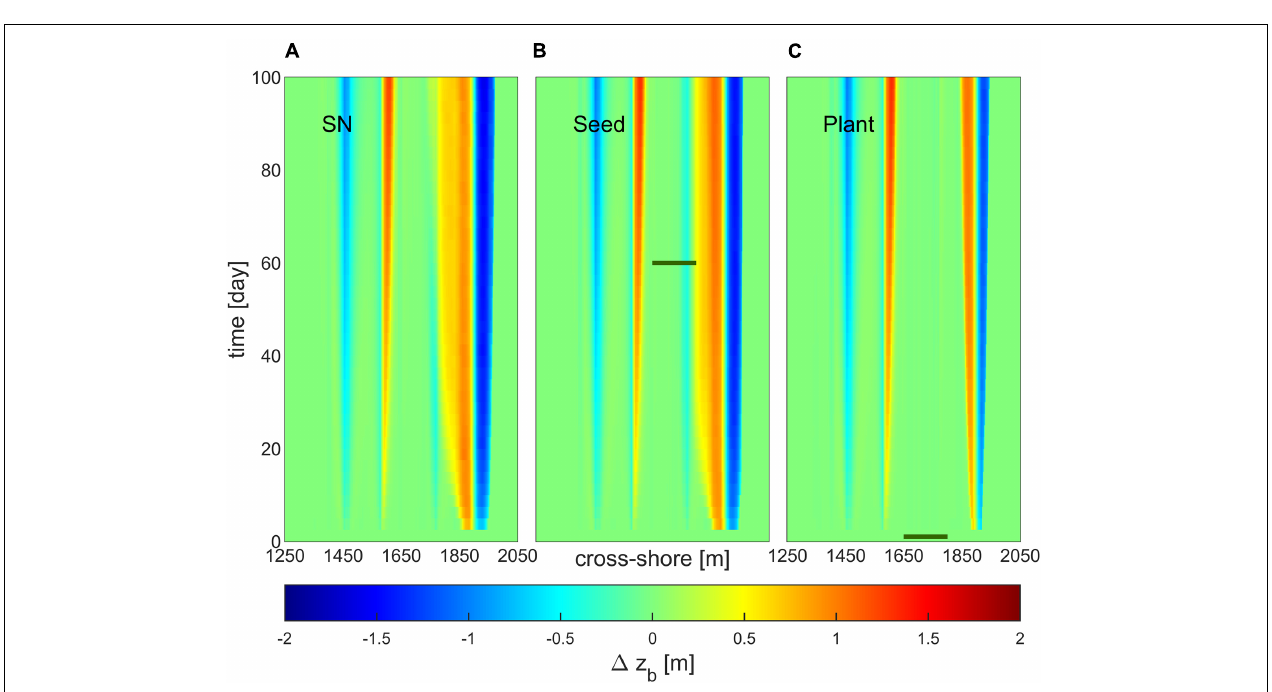
FIGURE 9 | Change of seabed over time for: (A) shoreface nourishment only; (B) seed planting assuming linear growing seagrass; (C) mature seagrass planting. Green lines indicate the range of the seagrass meadow and the mature timing of the plant.